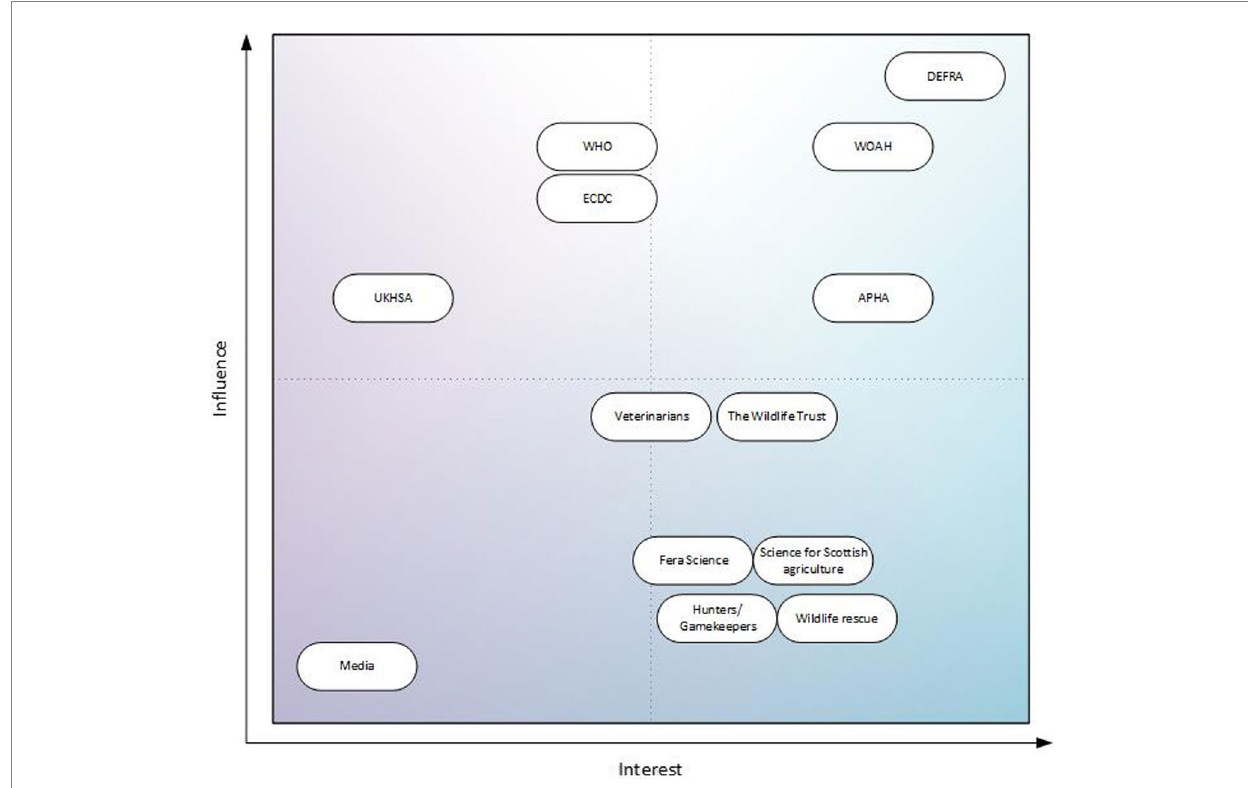
FIGURE 4 Stakeholders involved in GB E. multilocularis surveillance mapped to a Mendelow matrix, sorted by level of influence and interest in the surveillance